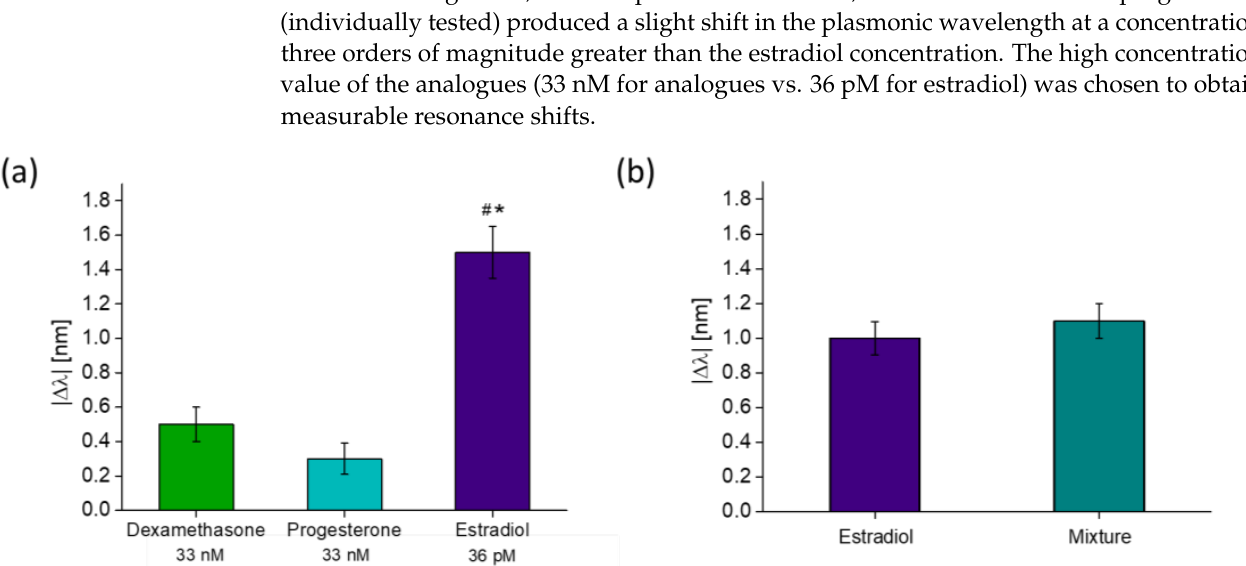
Figure 8. Selectivity test: ( a ) the absolute value of resonance variation for the structural analogues of estradiol (dexamethasone 33 nM and progesterone 33 nM) together with estradiol (36 pM). One-way ANOVA * p < 0.05 vs. dexamethasone and # p < 0.05 vs. progesterone. ( b ) Comparison between the absolute value of resonance variation for only estradiol 3.6 pM with a mixture of estradiol and the two structural analogues each considered at a concentration of 3.6 pM. The error bars were cal- culated as a standard deviation of the dataset (n = 3).